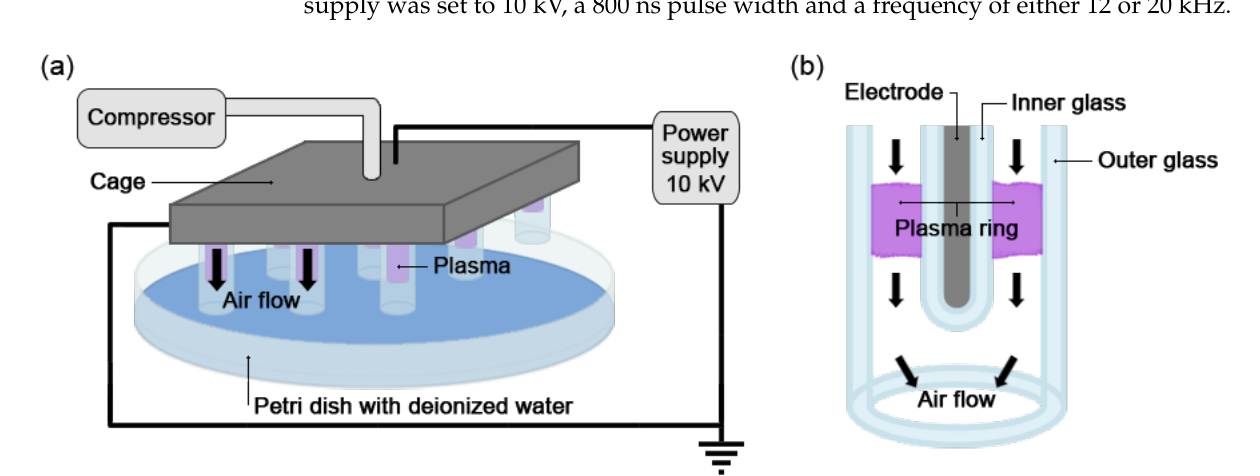
Figure 7. ( a ) Scheme of the dielectric barrier discharge (DBD) device and of the experimental set-up. ( b ) Details of one of the 13 electrode–glass tube components.